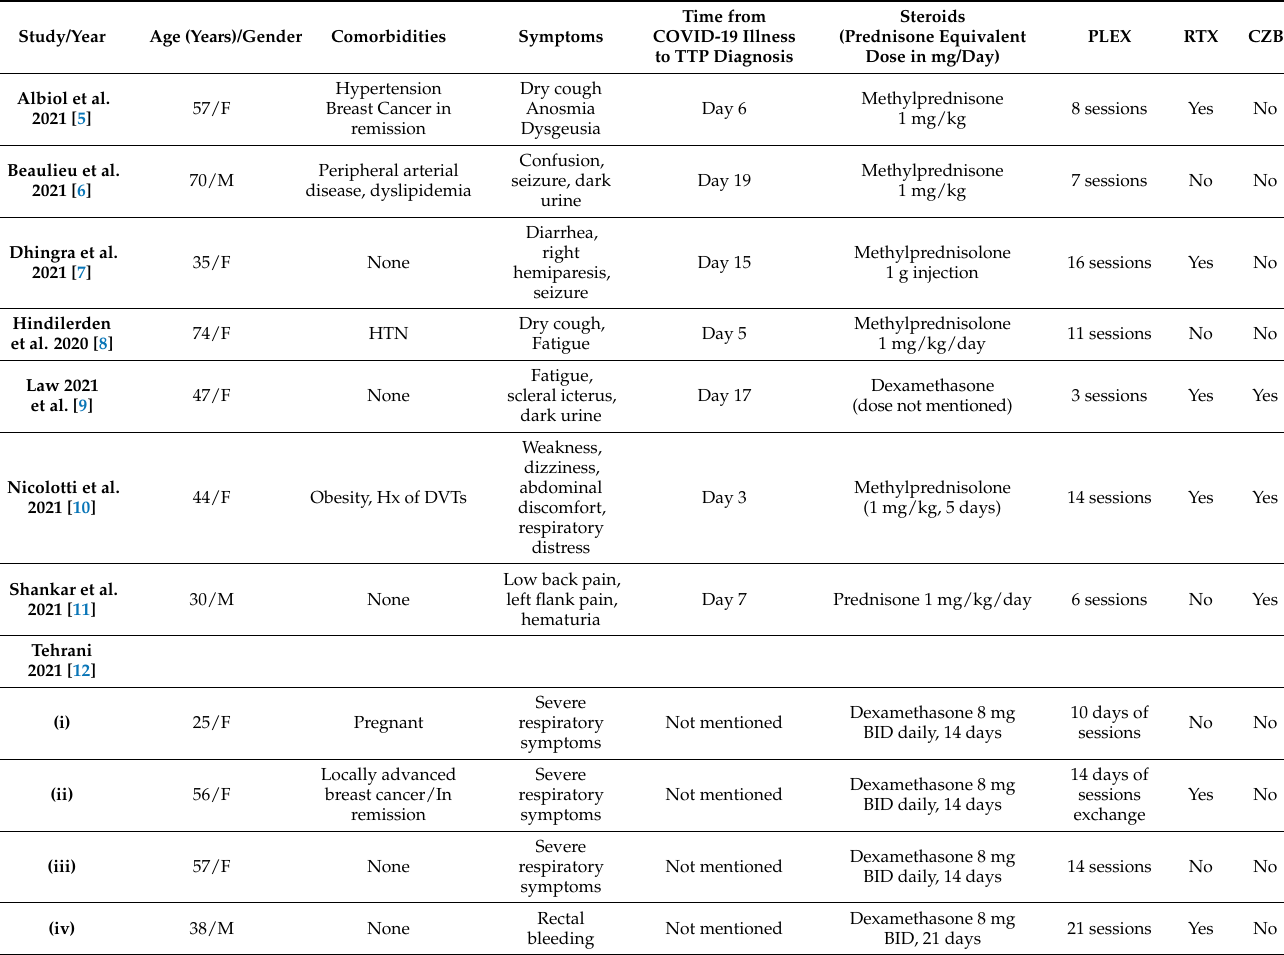
Table 1. Patient symptomatology, time to diagnosis, and treatment of